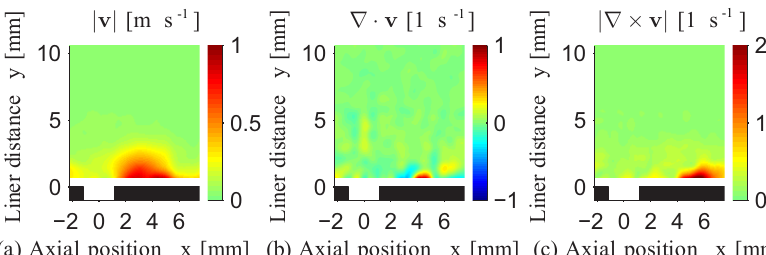
Figure 5. (a) Measured input vector field, i.e., phase-averaged oscillation velocity v , (b) its divergence ∇ · v , and (c) curl ∇ × v for a selected phase ϕ = 2 π at the lateral position z = 0 (see Fig. 4); vectorial quantities are depicted regarding their l 2 norm.